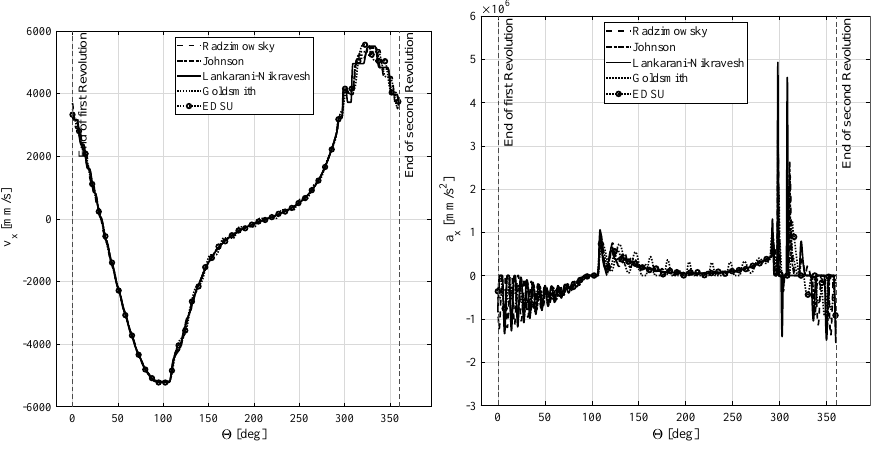
Figure 16. Slotted slider